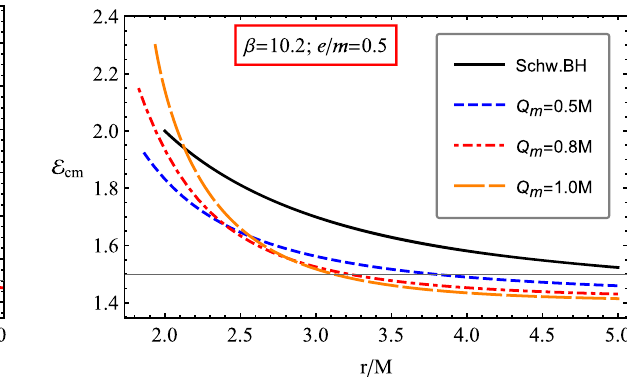
of the magnetic charge Q m of the black hole. Top (bottom) panel cor- responds to the cases of collisions between magnetized particles with the parameter β = 10 . 2 and negatively (positively) charged